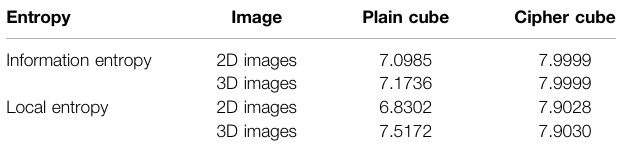
Information entropy and local entropy test